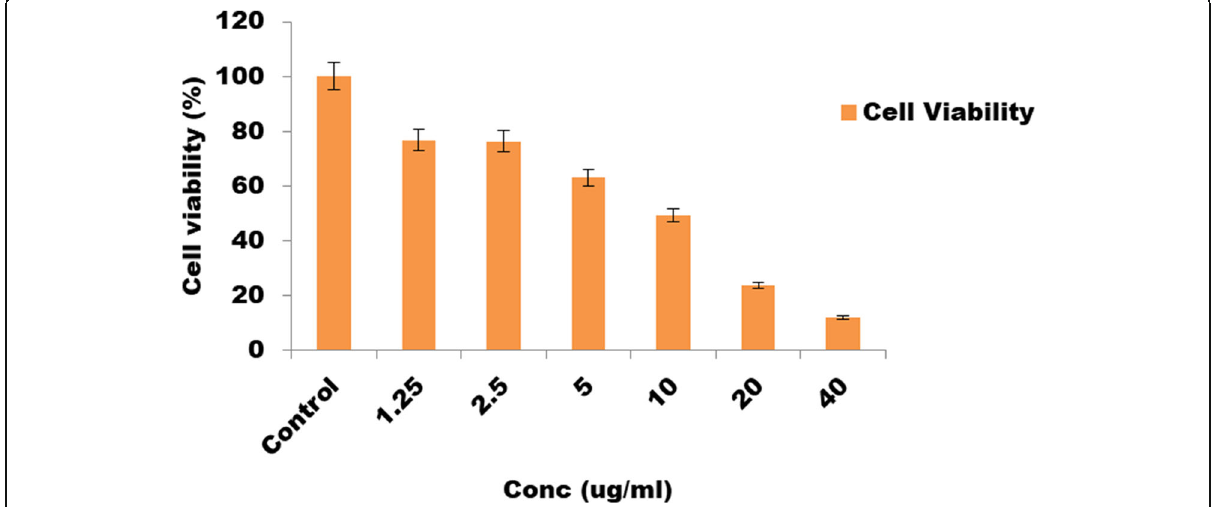
Fig. 7 Cell viability of H1299 cell line using methanol extract of Calotropis procera leaf. Data are expressed as mean ± SD ( n = 3)